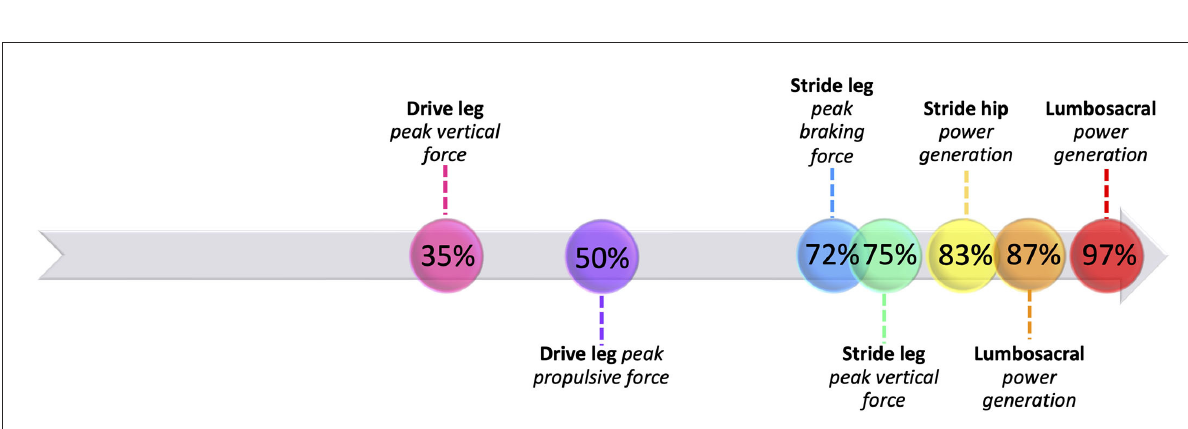
FIGURE12 A timeline of the most prominent biomechanical events during the pitch for developmental-aged